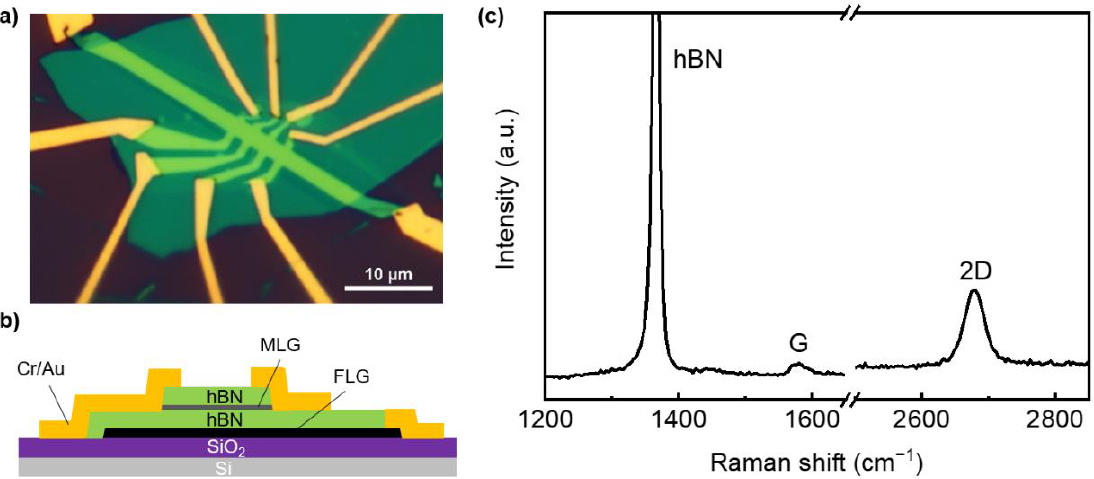
Figure 1. ( a ) Optical microscope image of the graphene quantum Hall device. ( b ) Schematic of the cross-section view of the hBN/MLG/hBN vdW heterostructure device. ( c ) Raman spectra of the hBN/MLG/hBN vdW heterostructure. The wavelength of laser is 532 nm, see Supplementary Material Section 2.